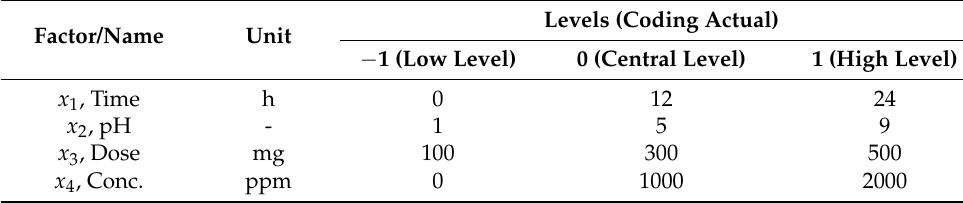
Table 6. Variable process factors of investigational levels of CCD.